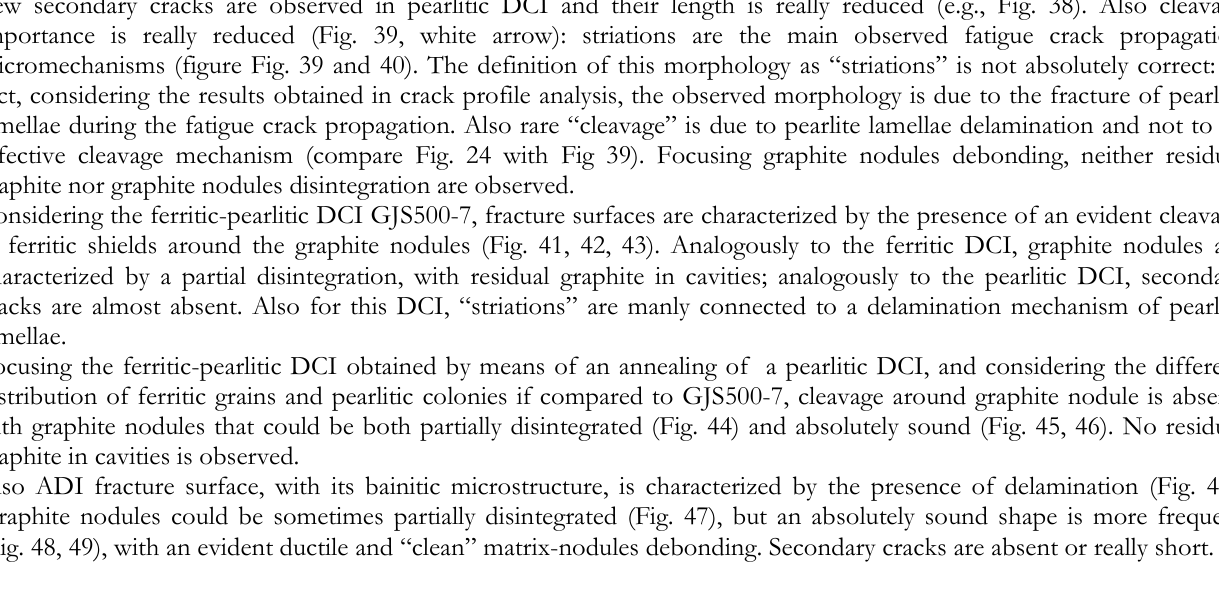
Figure 37: Ferritic DCI (R = 0.75,  K = 11 MPa √